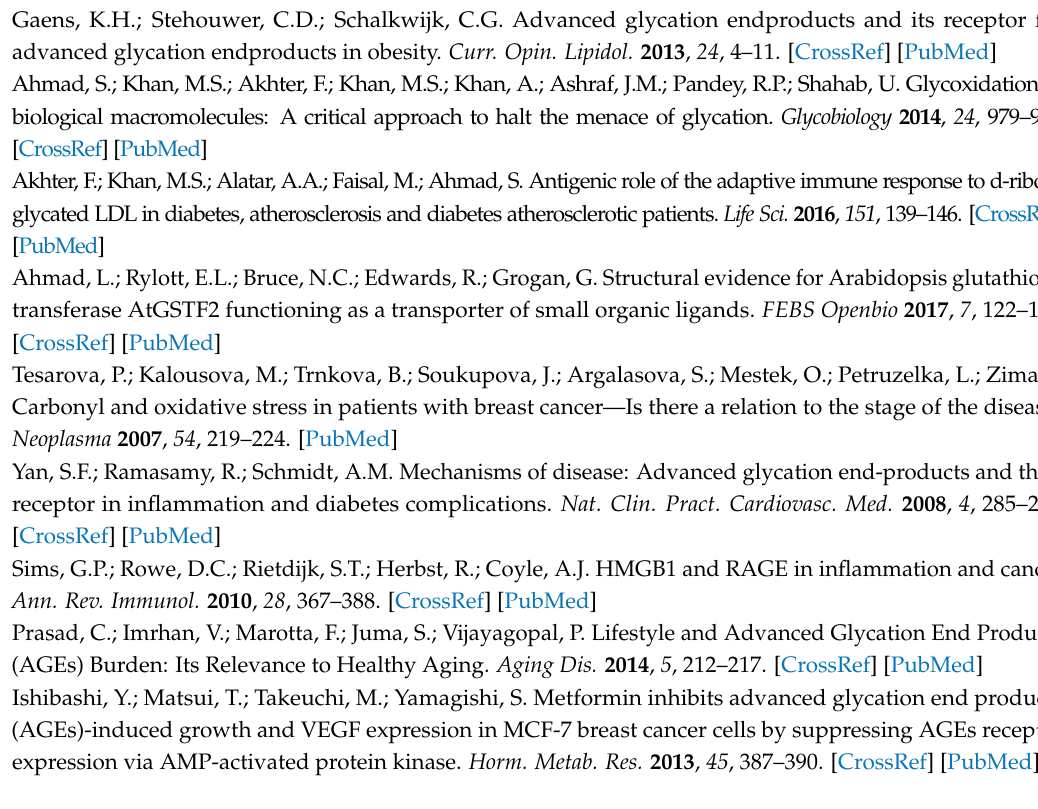
Table S1: Table describing patients age and sex (7 M–12 F; mean age 71.63+/ − 9.96), Table S2: Table reporting AGE fluorescence values (patients average: 1362 pg/ml +/ − 0,186; controls average 1517+/ − 0.152), Table S3: Average age values for male and female